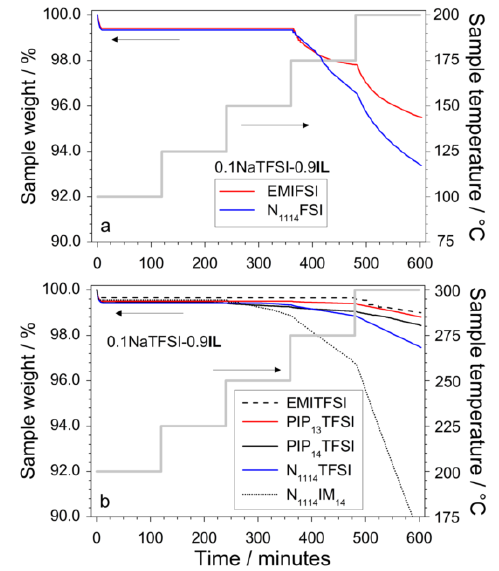
Figure 2. Isothermal TGA trace of 0.1NaTFSI-0.9IL sodium electrolytes: ( a ) FSI-based electrolytes; ( b ) TFSI- and IM 14 -based electrolytes. The sample temperature vs. time profile is represented by the stepwise grey trace.